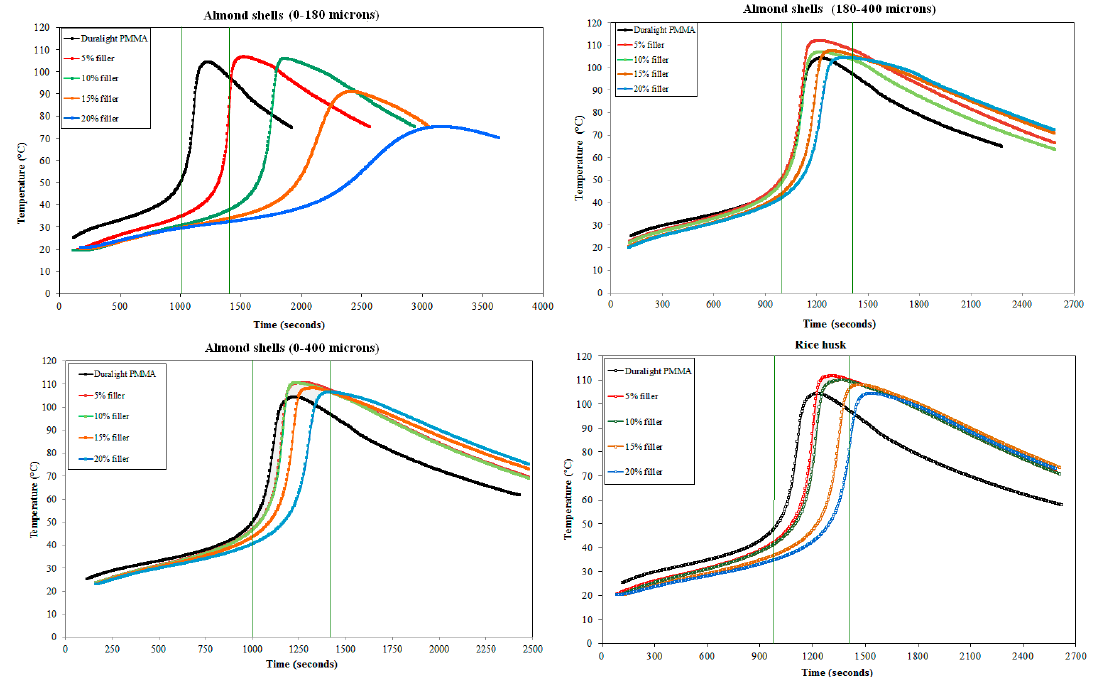
Figure 1. Temperature vs. time polymerization curves for different fillers in different amounts (the two vertical lines highlight the range of exothermic peak, which offers the optimal behaviour).